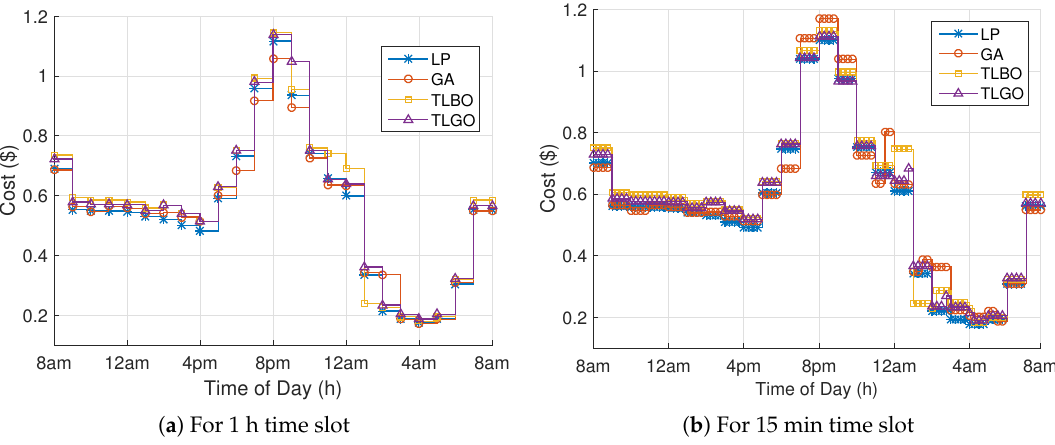
Figure 7. Electricity consumption cost under CPP.